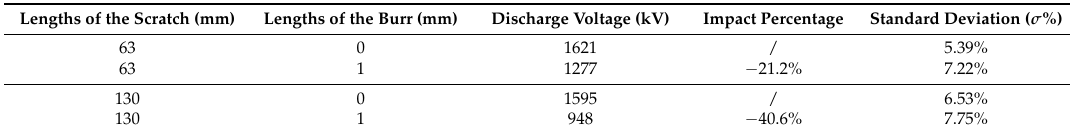
Table 1. Switching Impulse voltage U 50% with